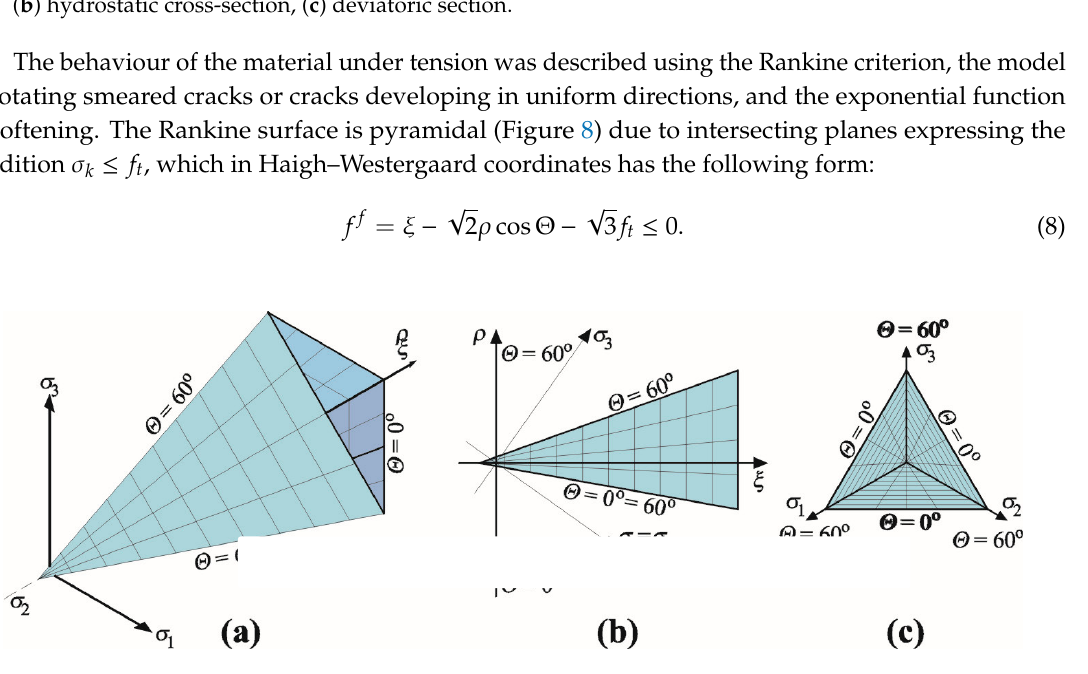
Figure 8. The Rankine criterion in Haigh–Westergaard space: ( a ) the space of principal stresses, ( b ) axiatoric section, ( c ) deviatoric section.